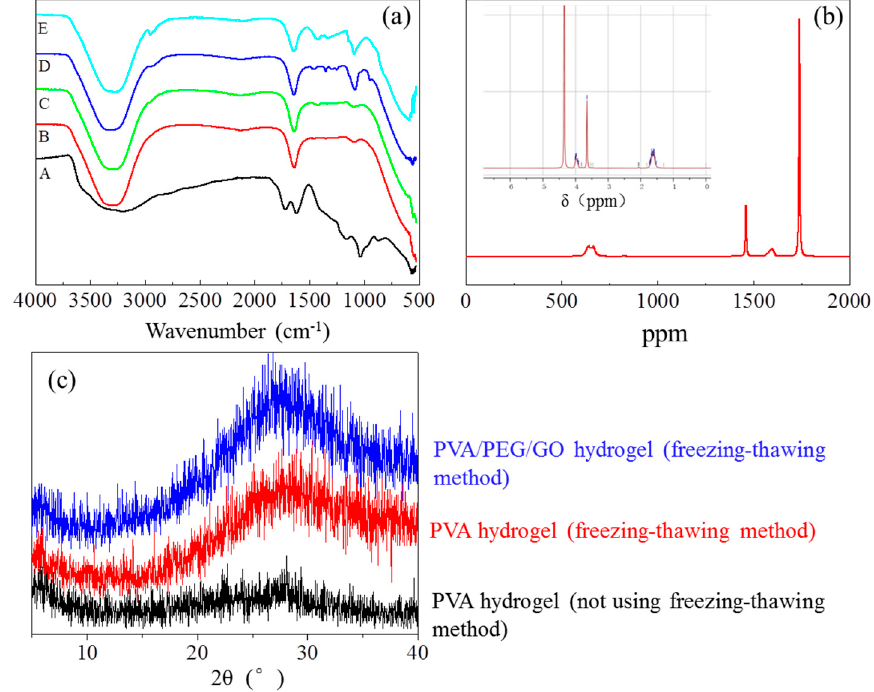
Figure 3. Crosslinking formation of hydrogel using characterizations of ( a ) infrared spectra of five materials, respectively, A—GO, B—PVA/PEG hydrogel, C—PVA, D—PEG, and E—PVA/PEG/GO hydrogel; ( b ) NMR spectra of PEG/PVA/GO hydrogel with a δ value from 1 to 2000 where the inset is a transition of the abscissa from ppm to δ ; and ( c ) XRD raw data of the PVA hydrogel using and without using the freezing–thawing method, and PVA/PEG/GO hydrogel using this gelation method; the raw spectra are marked with related interpretations, respectively.